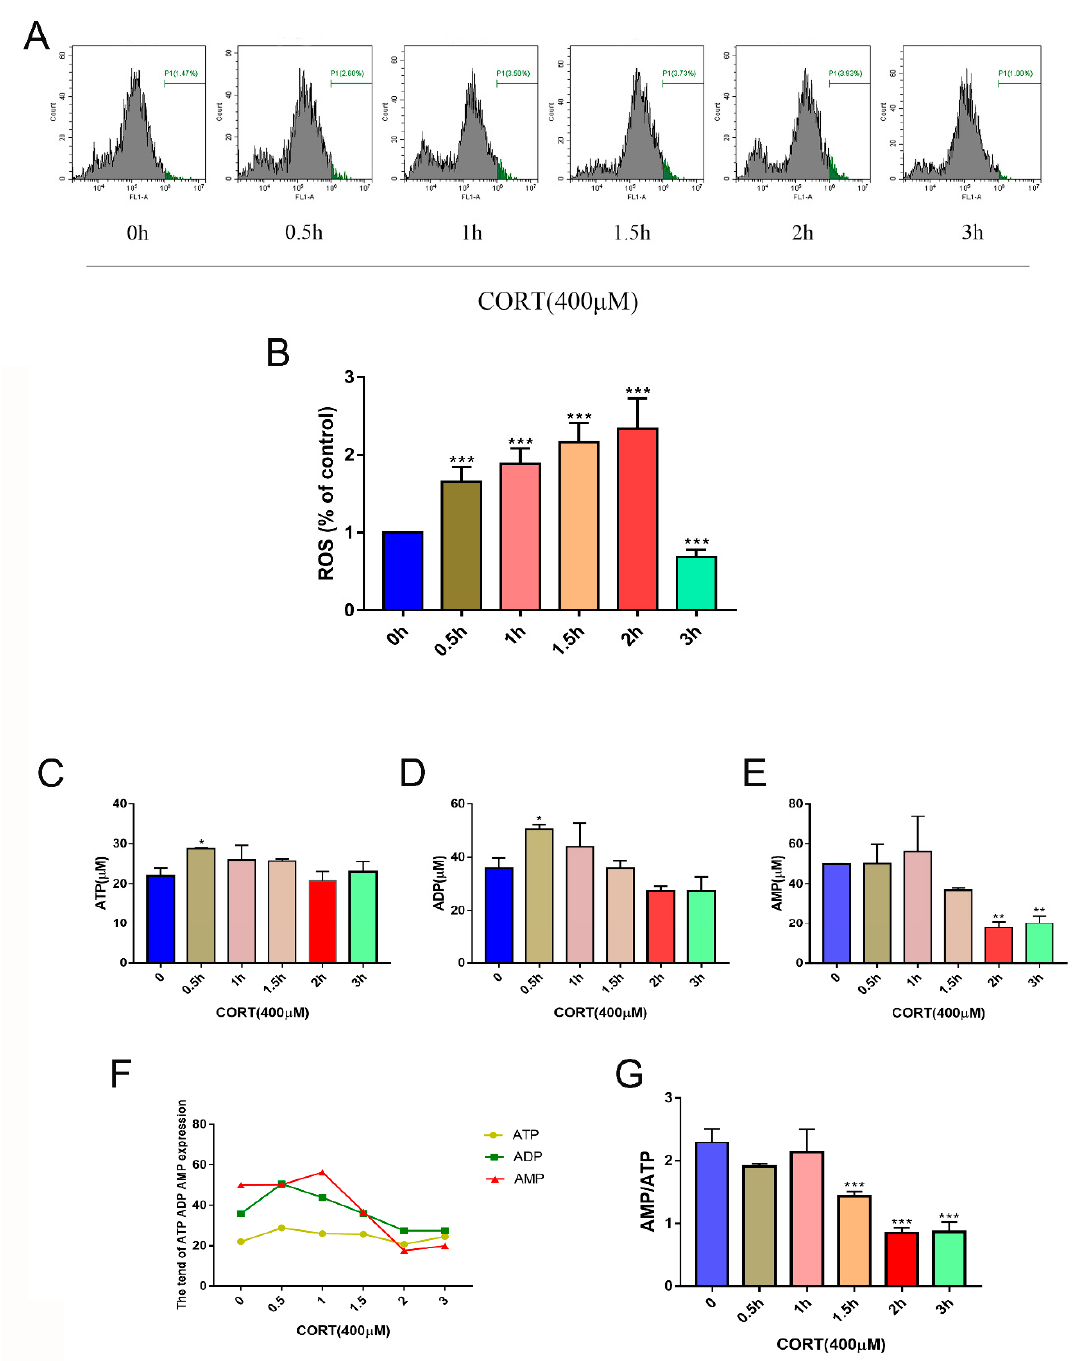
Figure 8. The levels of ROS released in HT22 cells after cortisol (CORT) treatment at different times (0–3 h) ( A ). The bar graph shows the levels of ROS released at every time point ( B ). Data were between control (CORT 0 μ M) vs. CORT (400 μ M) at different times, and were analyzed by one-way analysis of variance. The results are expressed as the mean ± SD ( n = 3) in each independent experiment; *** p < 0.001. The ATP, ADP, and AMP levels ( C – F ) in HT22 cells after CORT treatment at different times (0–3 h) were measured, and the ratio of AMP to ATP was determined ( G ). Data were between control (CORT 0 μ M) vs. CORT (400 μ M) at different times, and were analyzed by one-way analysis of variance. The results are expressed as the mean ± SD ( n = 3) in each independent experiment. NS: not significant; * p < 0.05; ** p < 0.01; *** p < 0.001.